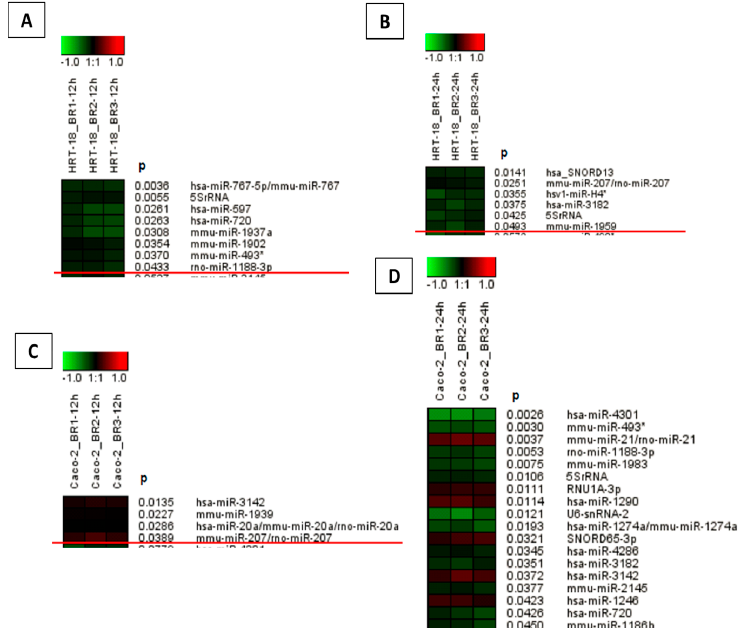
Figure 4. Microarray analysis identified several significantly differentially expressed miRNAs in the cell lines HRT-18 ( A , B ) and Caco-2 ( C , D ) upon sorafenib treatment compared to untreated controls ( p < 0.05, red line indicated the border for significantly differential expressed miRNAs). Non-coding small RNAs were ranked based on differential expression. ( A ) HRT-18 cell expression analysis after 12 h ( n = 3); ( B ) HRT-18 cell expression analysis after 24 h ( n = 3); ( C ) Caco-2 cell expression analysis after 12 h ( n = 3); and ( D ) Caco-2 cell expression analysis after 24 h ( n = 3).